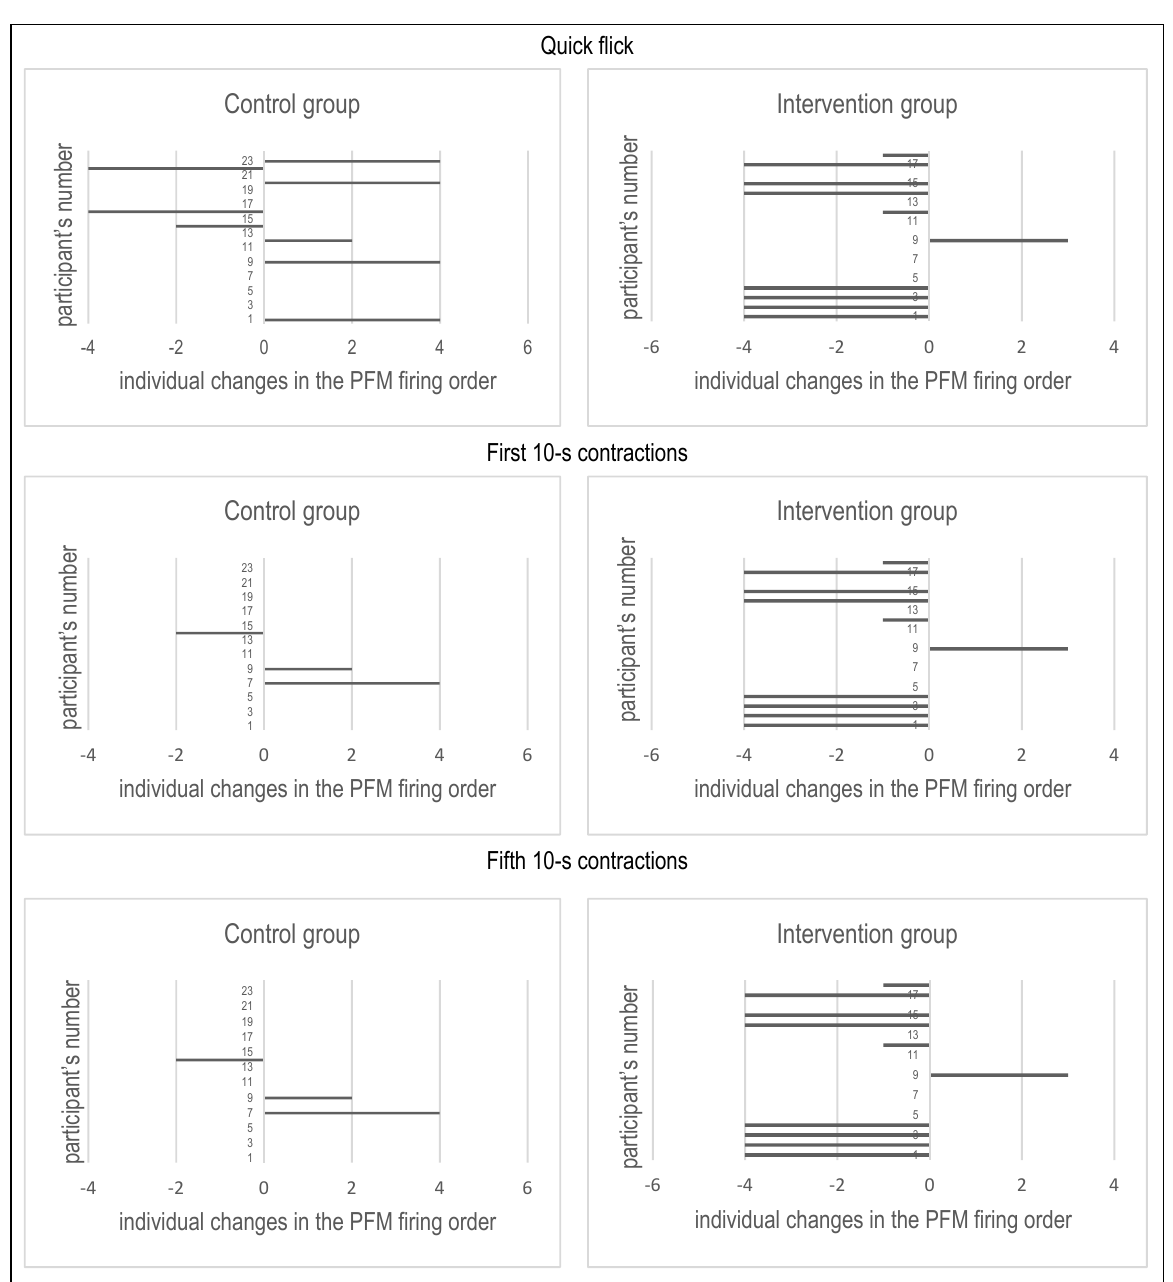
Figure 3. Individual changes in the firing order of pelvic floor muscles in selected motor tasks. Based on IIQ score, all women maintained good quality of life in terms of UI (Table 1). There was no deterioration in quality of life from participating in a high–low impact aerobics program. The intervention group after six-week training reported a reduction in the symptoms of uncontrolled urine leakage (pre 4.76 ± 4.90; post 3.46 ± 5.26) IIQ score.